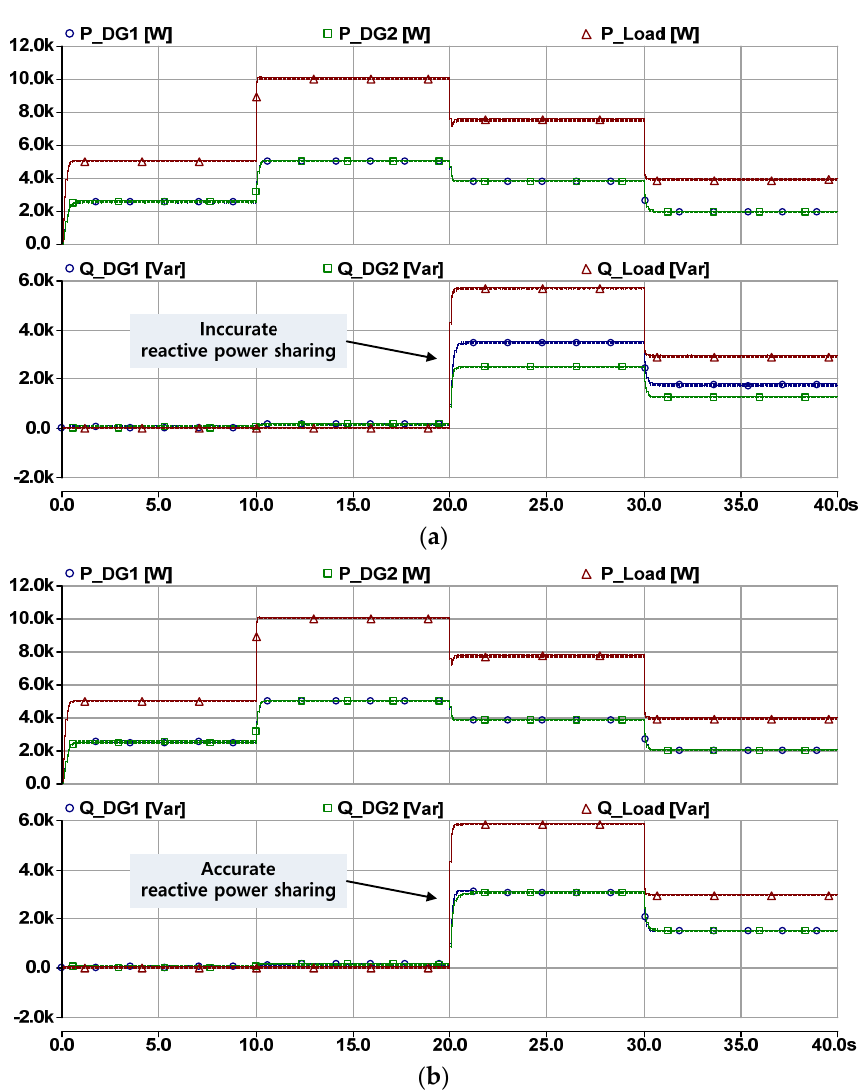
Figure 15. Simulation results of active and reactive power sharing for Case 1: ( a ) Existing droop ( b ) Proposed droop.